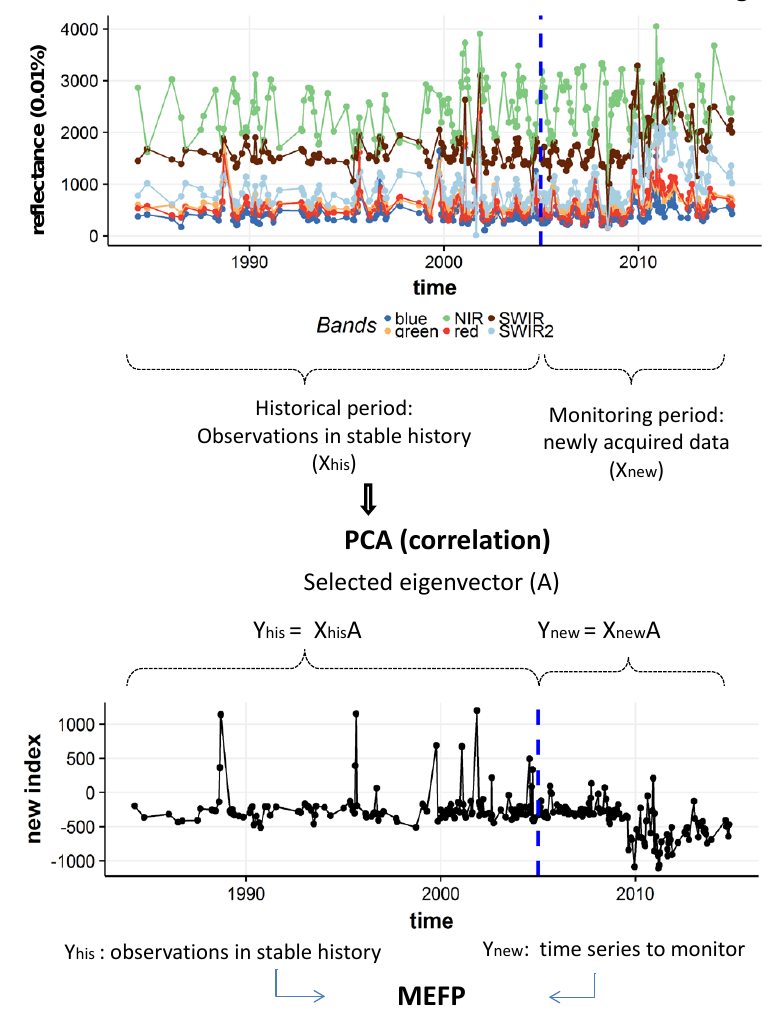
Figure 3. Diagram illustrating the proposed multispectral time series change monitoring method. PCA: Principal Component Analysis, MEFP: Monitor of Empirical Fluctuation